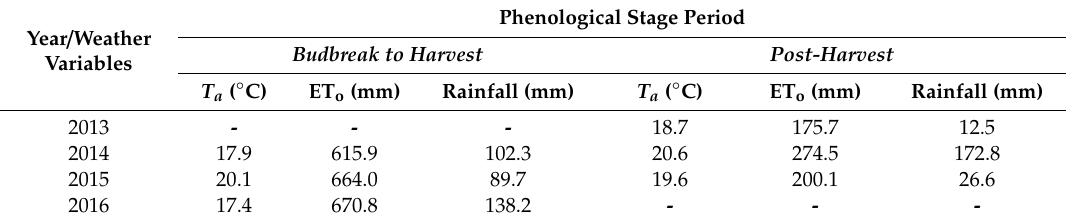
Table 1. Reference values for average air temperature ( T a ), evapotranspiration (ET O ) and rainfall for the di ff erent phenological stages during the